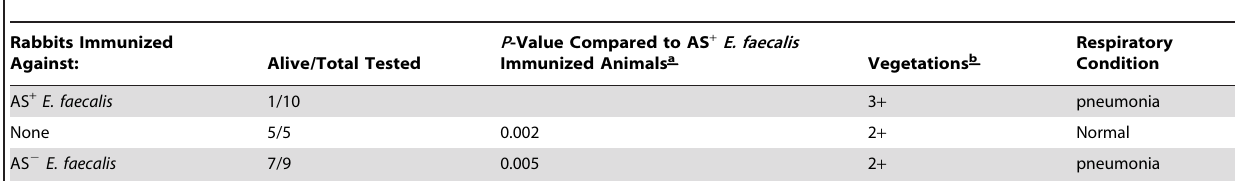
Table 2. Active immunization against AS + E. faecalis worsens infectious endocarditis after challenge with AS + enterococci.